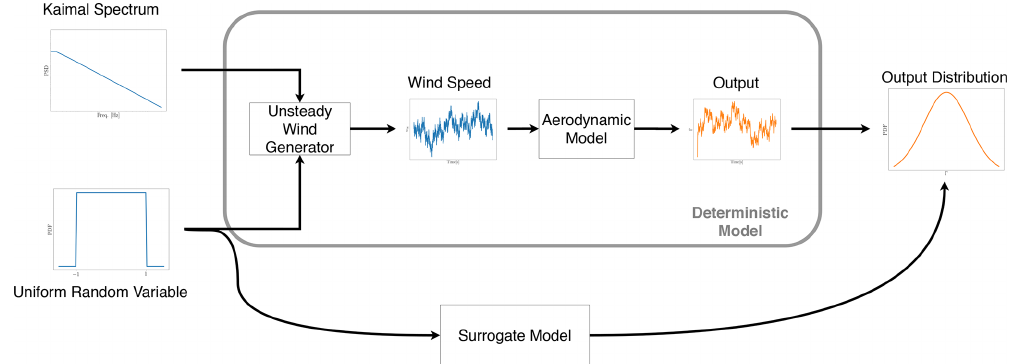
Figure 1. The common deterministic process of aerodynamic modeling vs. the suggested surrogate model method schematic flow chart.